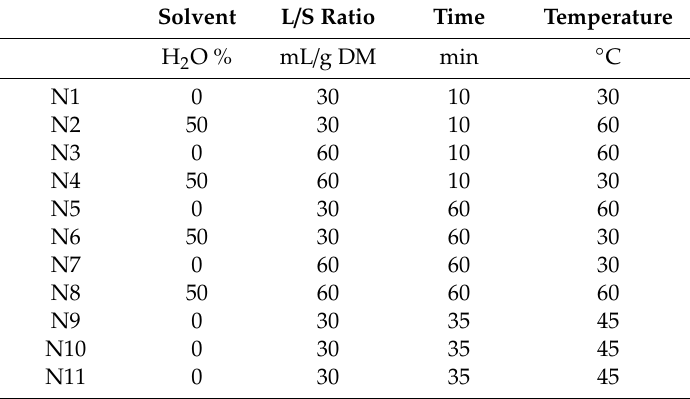
Table 3. Worksheet with experimental conditions for